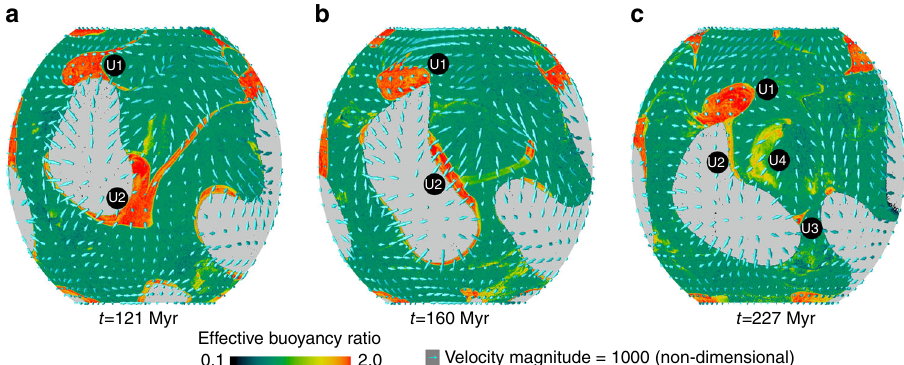
Fig. 4 Time evolution of the location and morphology of ultradense material patches. a – c Composition fi eld (represented by effective buoyancy ratio) at 5 km above the CMB showing locations of ultradense material ( reddish ) and pile material ( greenish ). The yellowish color shows a mixing of ultradense material with pile material. The cyan arrows show mantle fl ow velocity. U1, U2, U3, and U4 are markers that track the patches of ultradense material, as explained in the text. Light gray color represents Earth ’ s